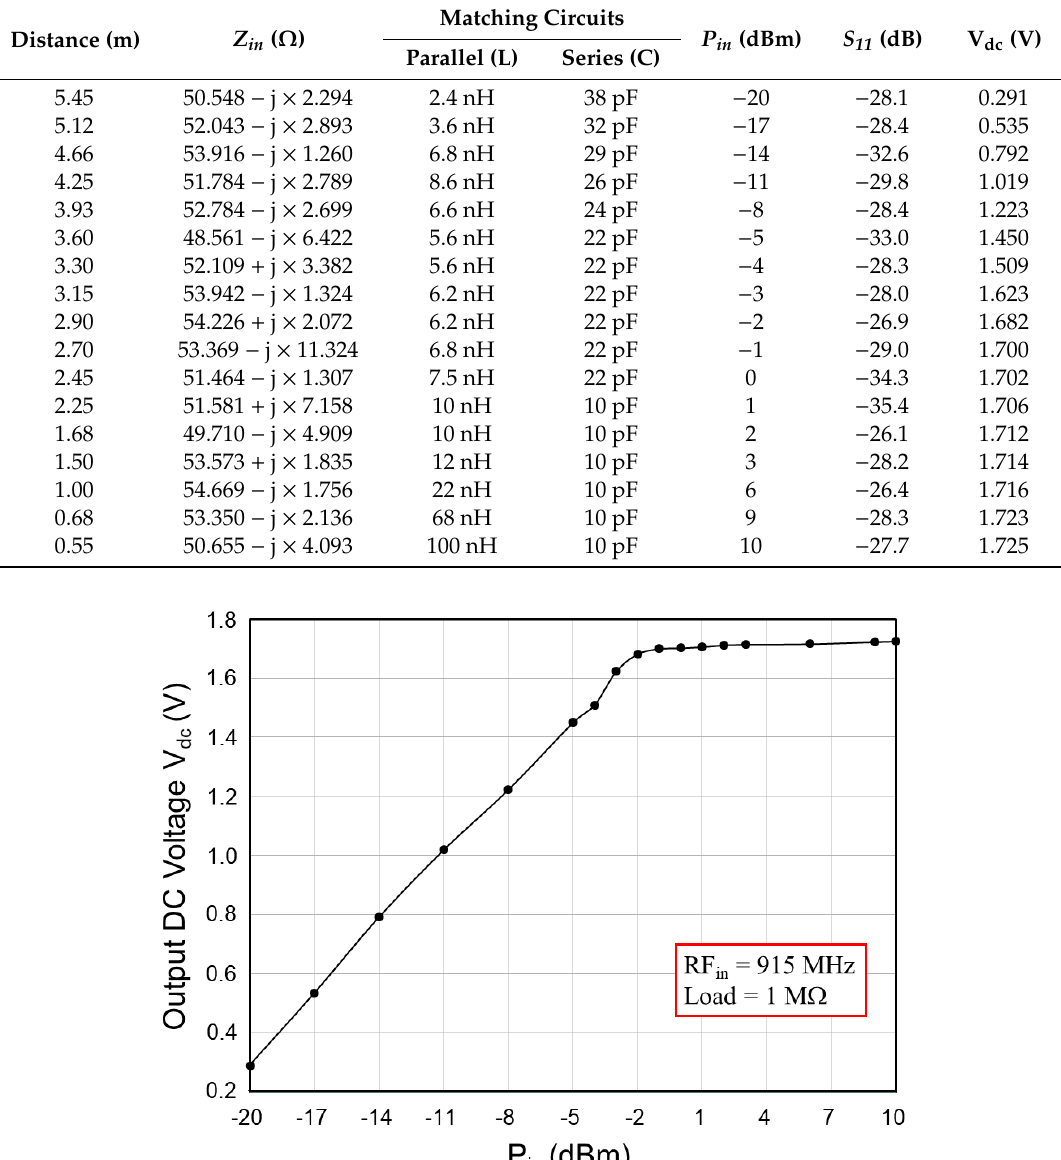
Table 3. Measured input power P in (dBm), input return loss S 11 (dB), and output DC voltage V dc (V) with respect to distance (m) between the transmitter and test PCB, input impedance Z in ( Ω ) and its corresponding matching circuits [L (nH) and C (pF)] for the RF-DC rectifier with the over-voltage protection circuit.